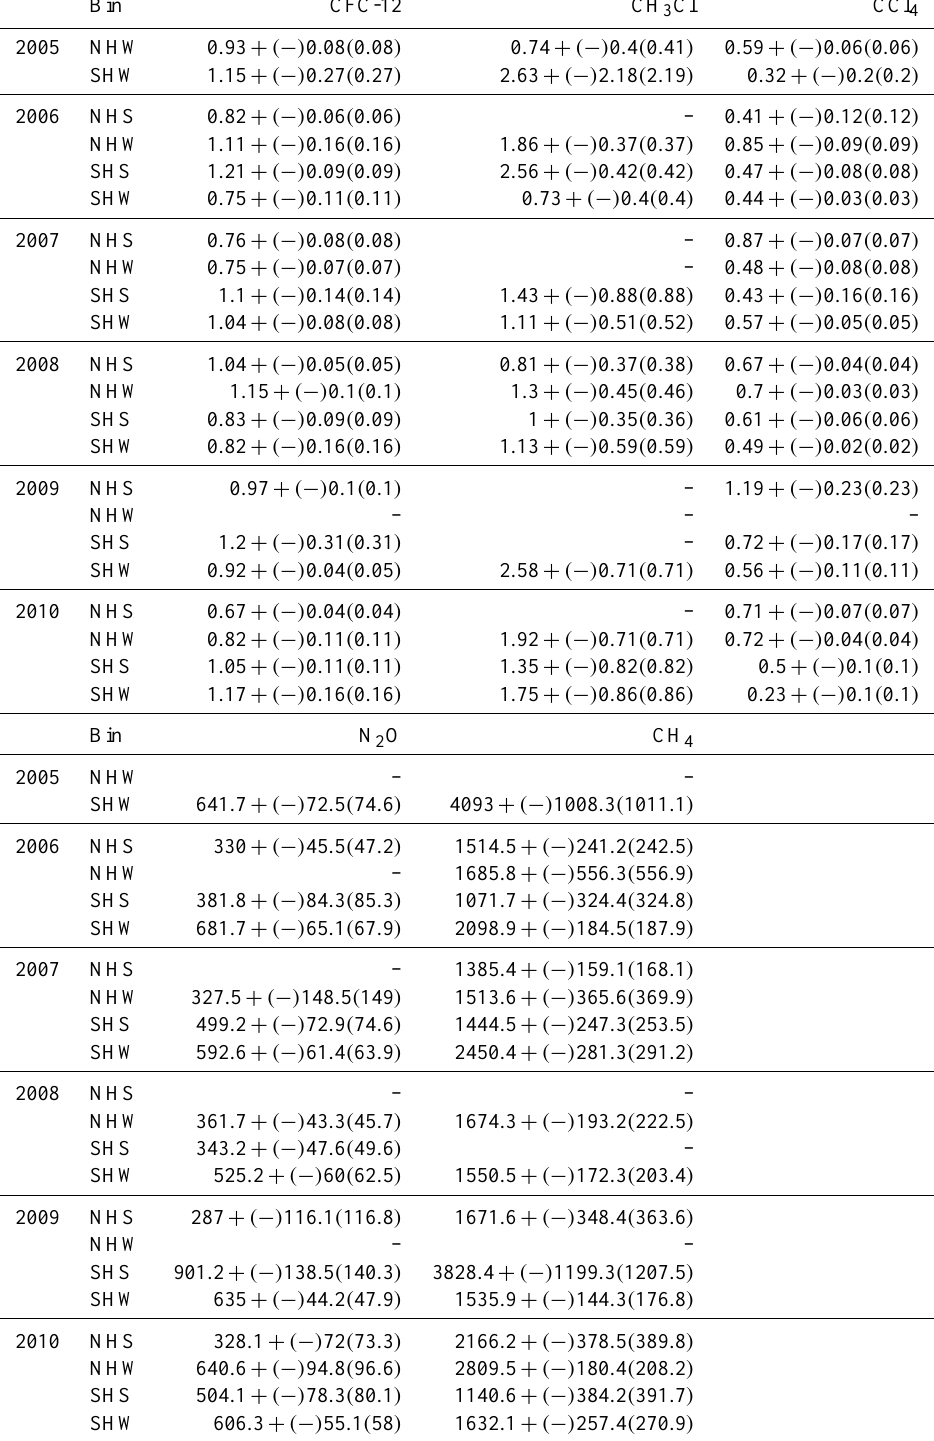
Table A3. The corrected slopes of the correlations of CFC-12, CCl 4 , CH 4 , CH 3 Cl and N 2 O with CFC-11, extrapolated to the tropopause. NHS is Northern Hemisphere summer, NHW is Northern Hemisphere winter, SHS is Southern Hemisphere summer, SHW is Southern Hemisphere